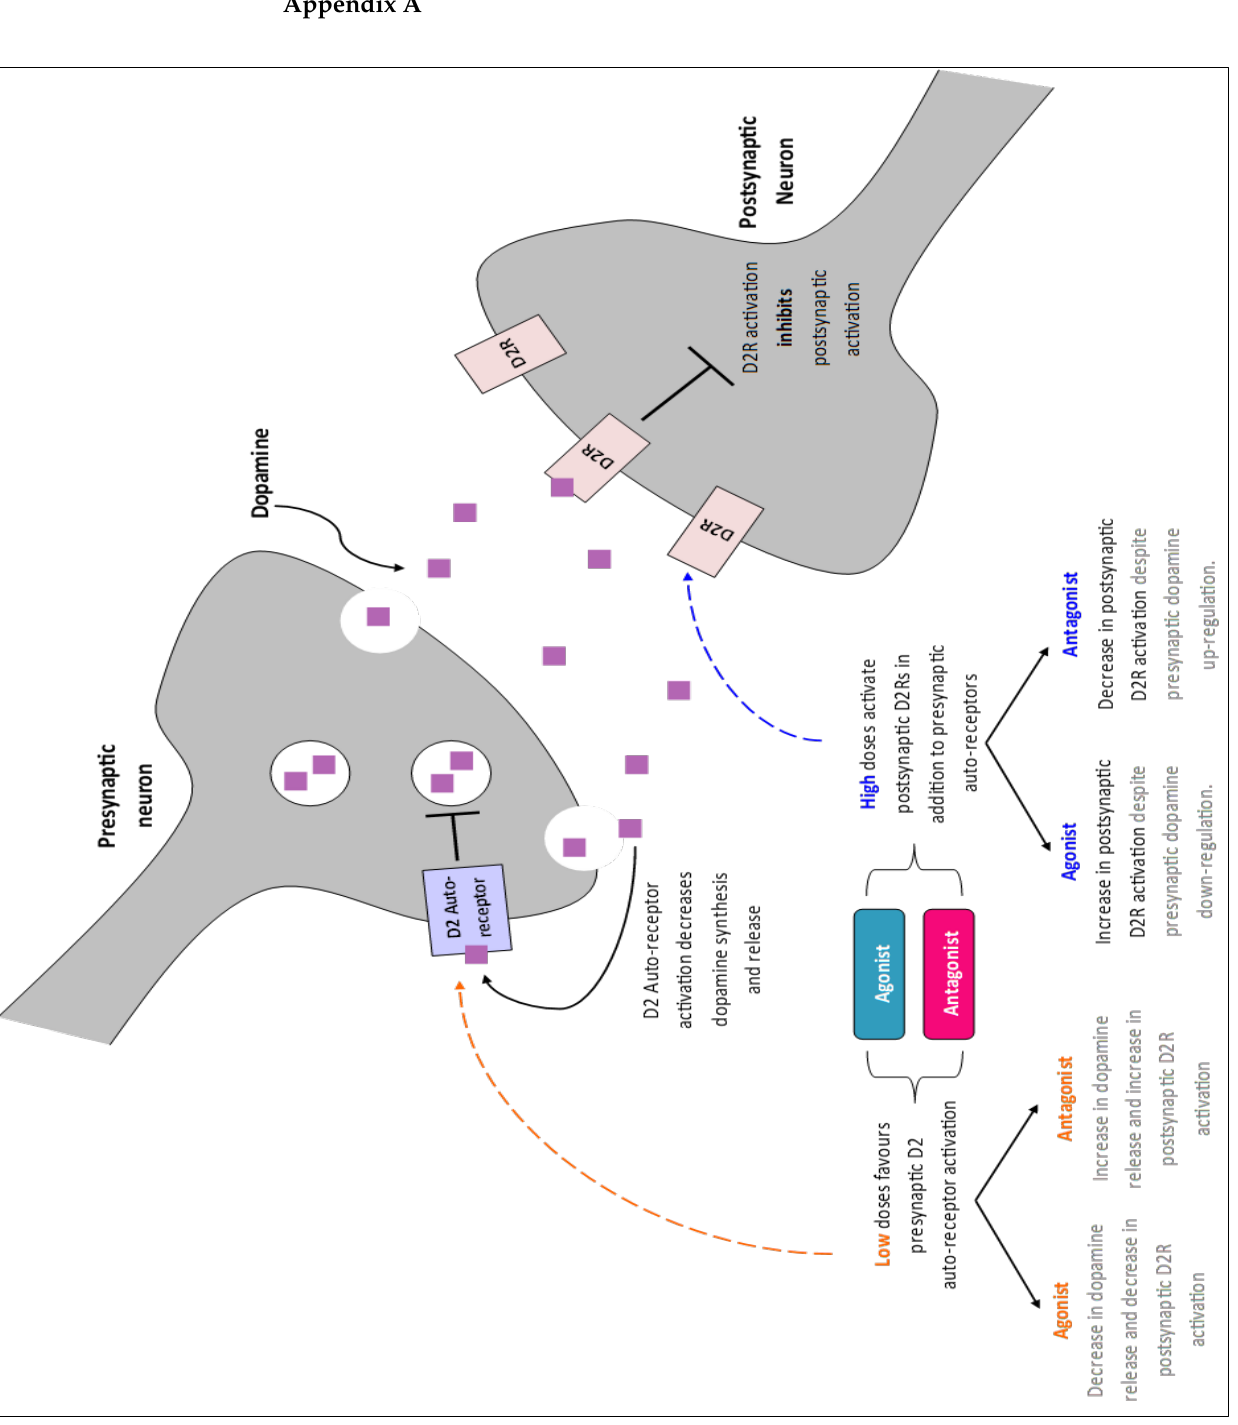
Figure A1. A schematic diagram of the action of the dopamine D2 receptor and how low and high doses of agonists and antagonists have different effects on postsynaptic D2 receptor activity. Presents the scientific rationale for using a high dose of both drugs in the current study.